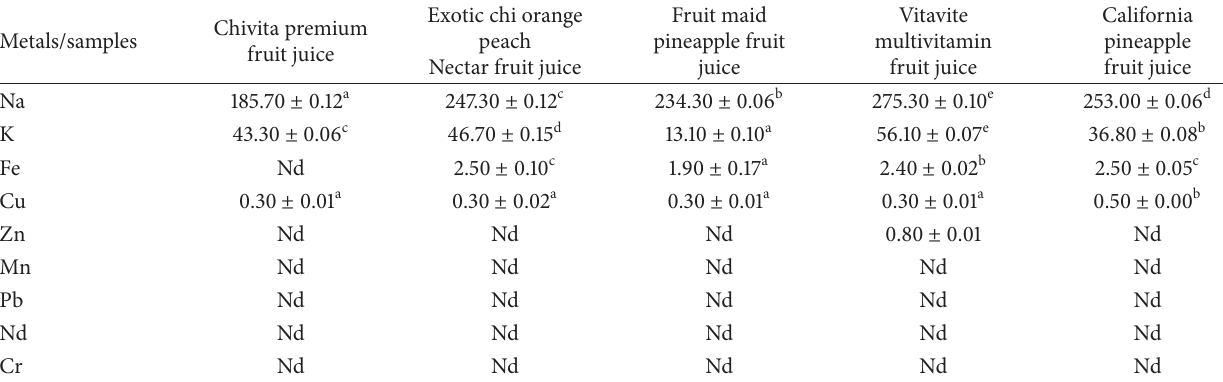
Table 3: Trace metal and mineral content in different Sachet fruit juices